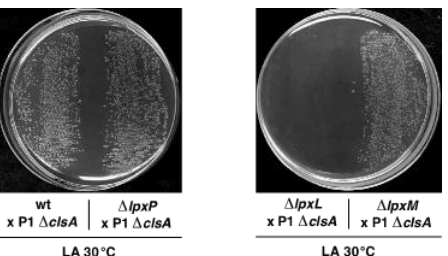
Figure 5. Synthetic lethality of Δ( lpxL clsA ). Exponentially grown cultures of the wild type and its isogenic deletion derivatives—individually lacking lpxL , lpxM, and lpxP —were used as recipients for bacteriophage P1-mediated transduction in order to introduce the Δ clsA mutation. Transductants were plated at 30 °C in LA agar and incubated for 24 h. Data presented are from one of the representative experiments.